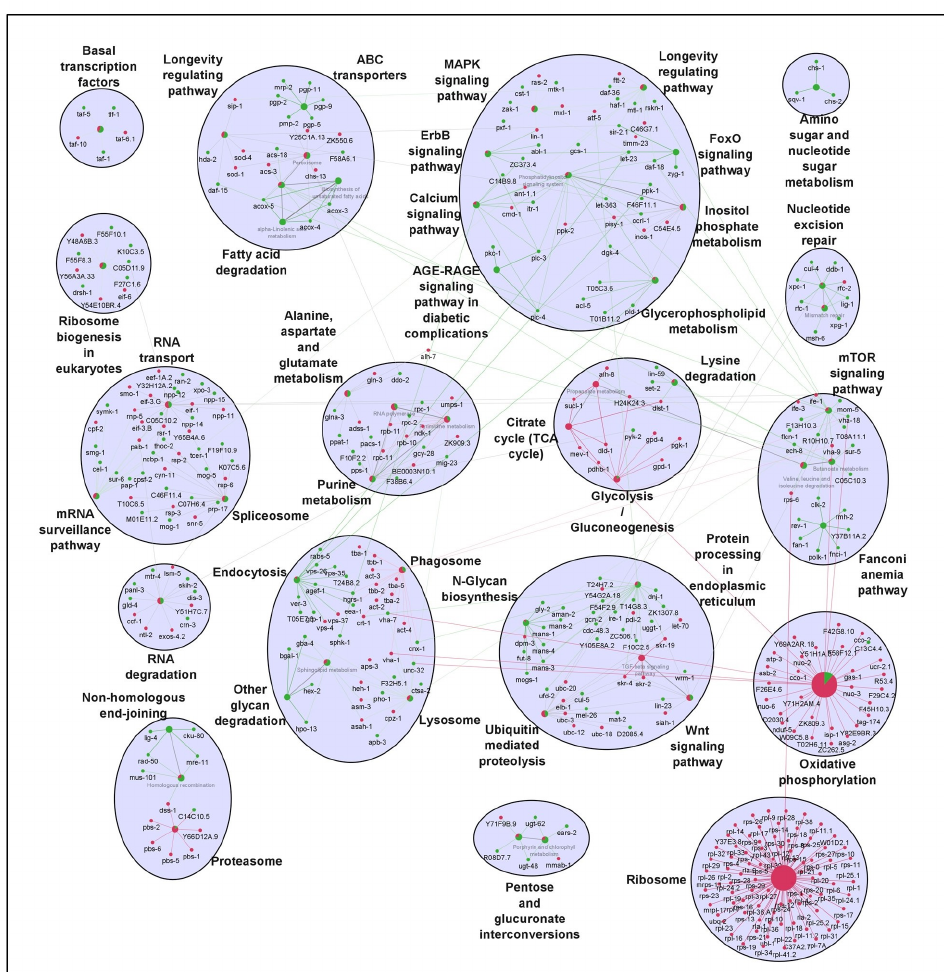
Figure 7. Gene network of HSF-1-regulated genes downstream of the rIIS condition. HSF-1 regulates multiple diverse pathways. Several pathways, including longevity, amino sugar, nucleotide sugar, ABC transporters, non-homologous end-joining, and mTOR signaling, mainly involve gene activation. Meanwhile, ribosome, proteosome, glycolysis, TCA cycle, and oxidative phosphorylation-related genes were found to be repressed by HSF-1. Activated and repressed genes are shown by green and red colors,